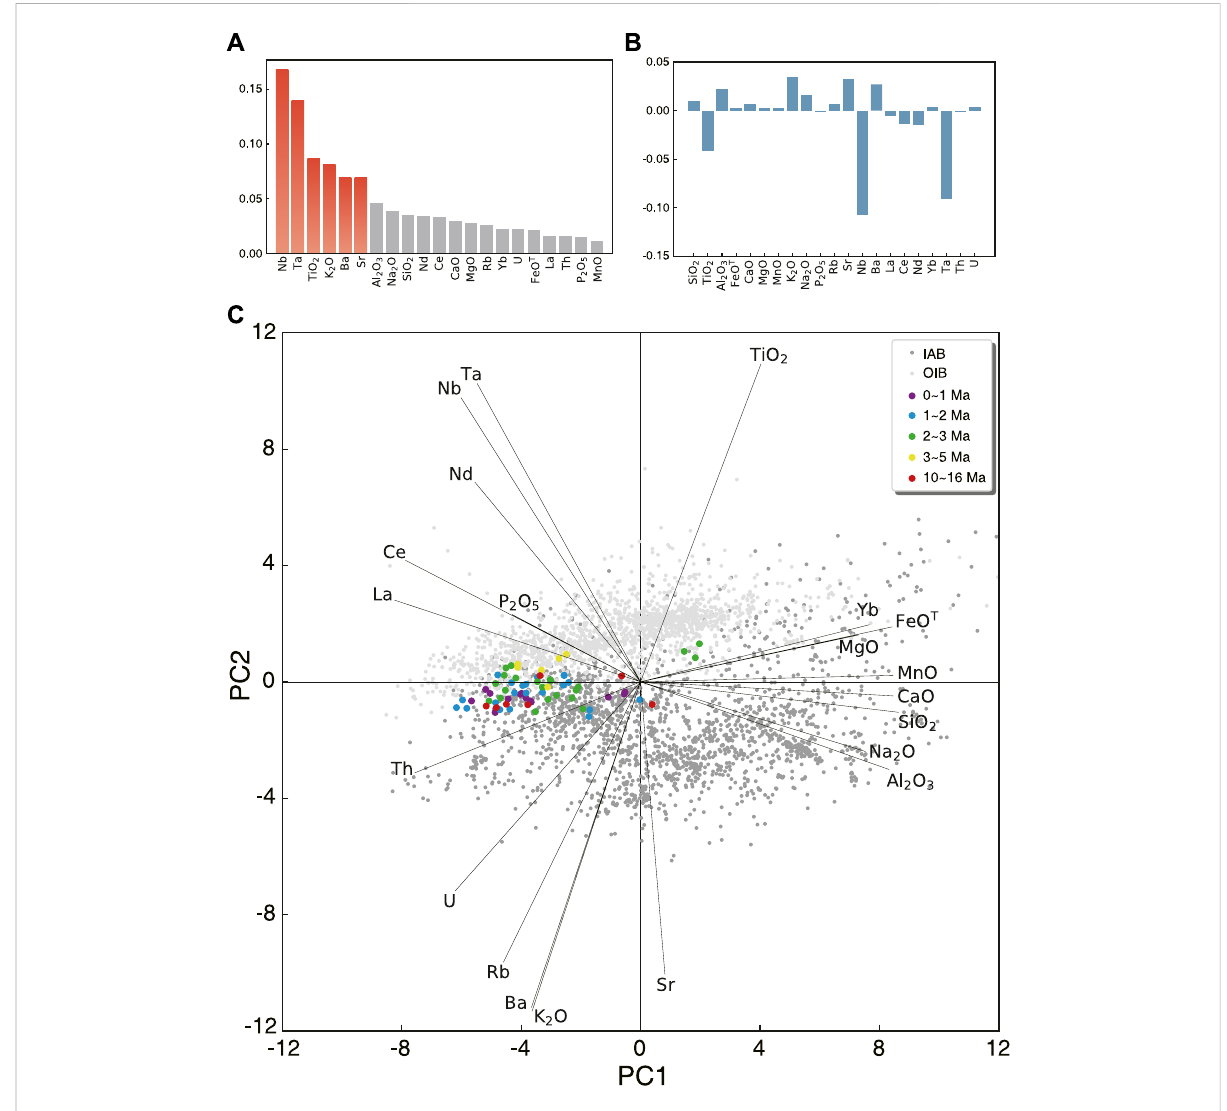
FIGURE 5 (A,B) FeatureimportanceextractedfromRFmethodafterZhaoetal.(2019). (C) CompositionalbiplotofbasaltsfromtheCBSarea,islandarcand ocean island according to Zhao et al. (2019). Black lines mean the PC loadings for each element. A relatively large value signi fi es a large contribution of the element to the corresponding principal component. PC is principal